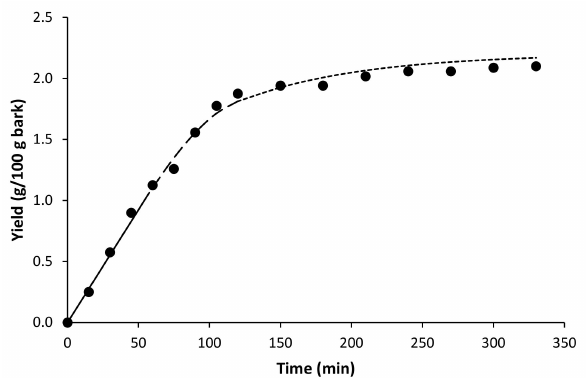
Figure 4. Kinetic extraction curve for the supercritical extraction of Paulownia bark at 30 MPa and 45 ◦ C. Lines represents the BIC model: (—) CER period; (– – –) FER period; ( --- ) DC